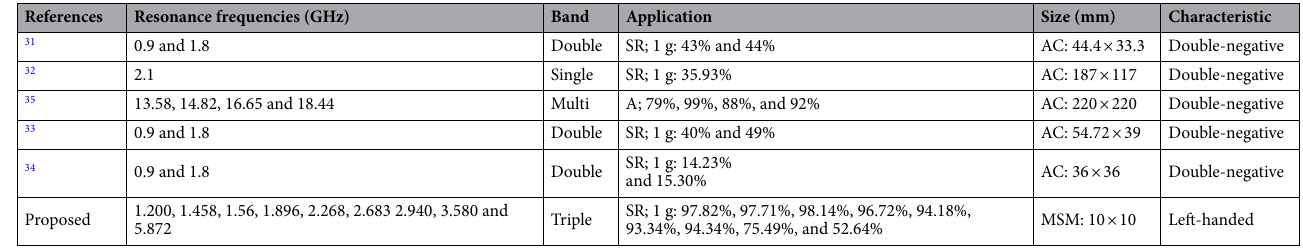
Table 12. A comparison between proposed metamaterial design and previous studies. SR SAR reduction, A absorption, AC array